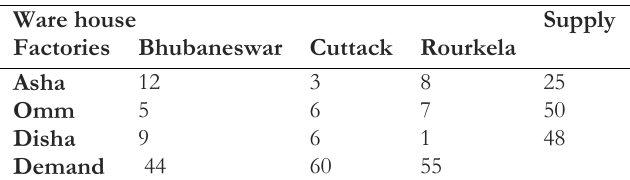
Table 3. The defuzzified pentagonal Neutrosophic transportation problem.